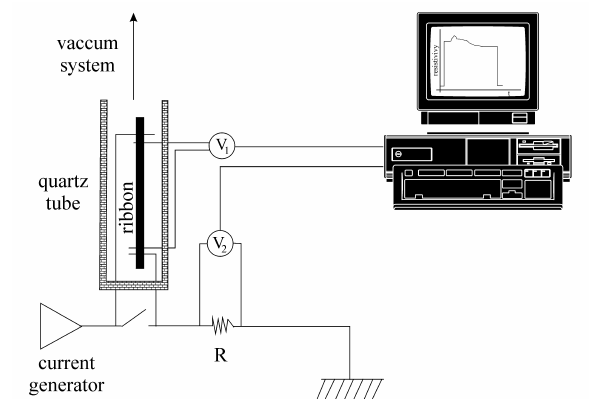
Figure 2. Experimental setup for the flash annealing process. Figure 1. DTA measurement at 10 °C/min for ribbon Pr 4.5 Fe 77 B 18.5